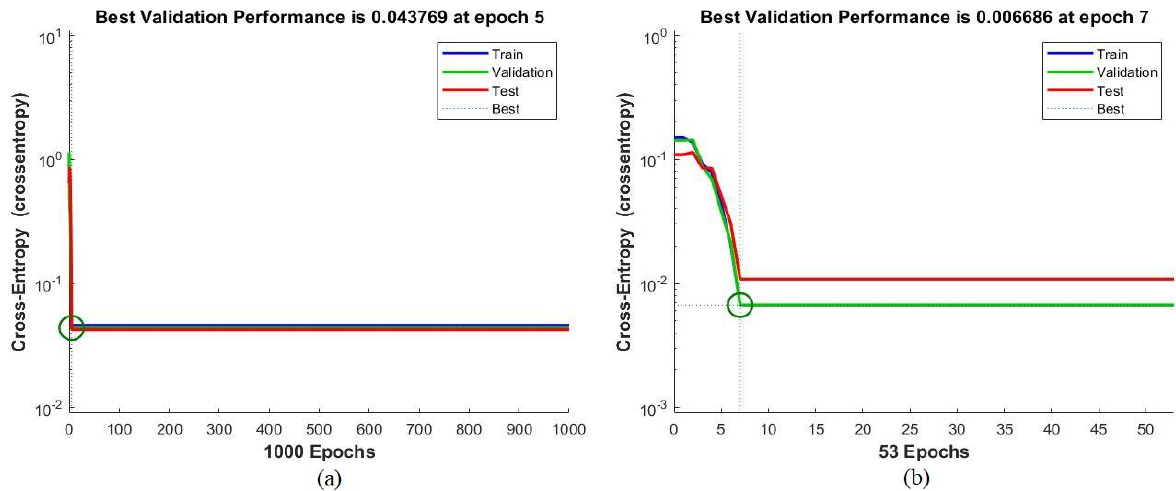
Figure 13. Performance of the artificial neural network classifier of the ( a ) ALL_IDB1 and ( b ) ALL_IDB2 datasets.